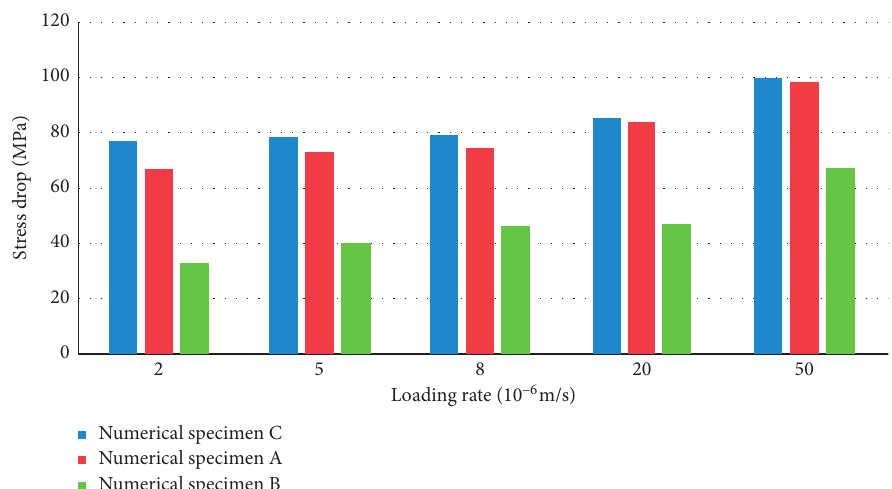
Figure 10: Longitudinal contrast of stress drop of three kinds of numerical specimens.